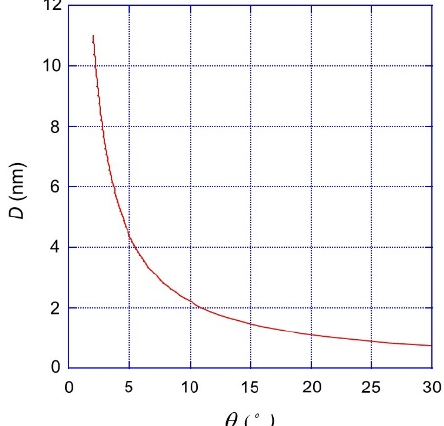
Figure 15. Dislocation distance D as a function of misfit angle θ in the boundary.